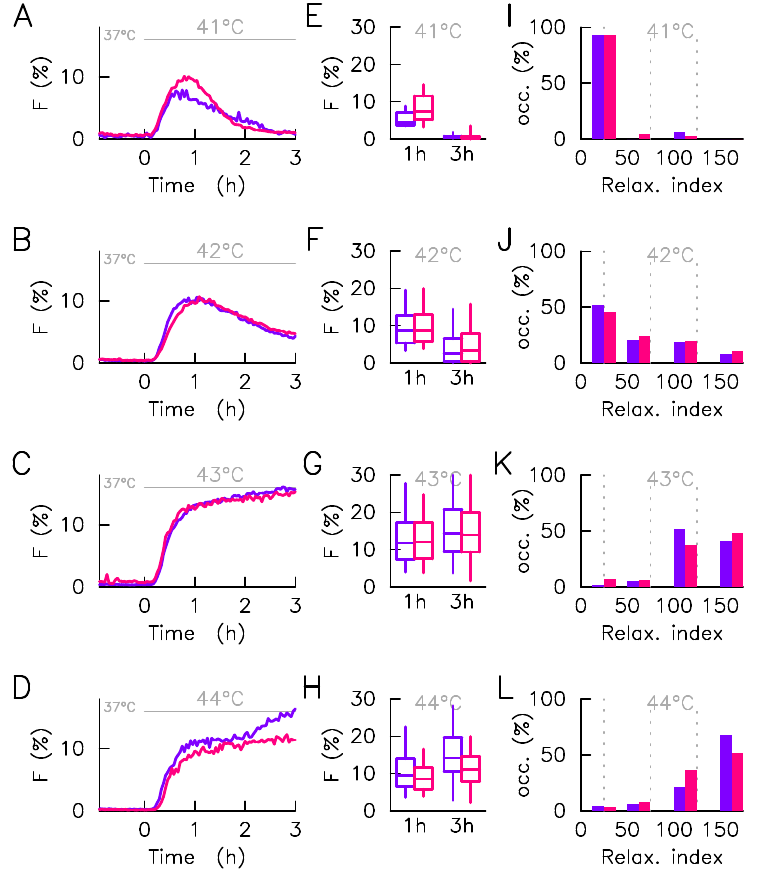
Figure 5. Cell-to-cell variability of responding cells in heat shock response. The HSF1:eGFP fluo- rescence and fraction of HSF1:eGFP fluorescence in nSBs ( F ) are monitored over time in a single cell upon a 41–44 ◦ C heat stress, time zero coincides with the stress onset. Each line of the plot corresponds to a given stress condition. In all panels, measurements obtained with cells adhered to non-coated are displayed in red whereas those obtained with cells adhered to collagen-coated are displayed in blue. The statistical analysis is here restricted to responding cells. ( A – D )—Average foci intensity over time, the average is computed on responding cells only. ( E – H )—Distribution of foci intensity in responding cells displayed at two time points (1 h and 3 h post HS) by box-and-whisker plot ( whiskers represent 9th percentile and the 91st percentile). ( I – L )—Histogram of the relaxation index, four bins are used: 0 ≤ η < 0.25, 0.5 ≤ η < 0.75, 0.75 ≤ η < 1.25, and 1.25 ≤ η . The relaxation index is defined as the ratio of the foci intensity measured in a given cell at three hours after the stress onset to the one measured one hour after the stress